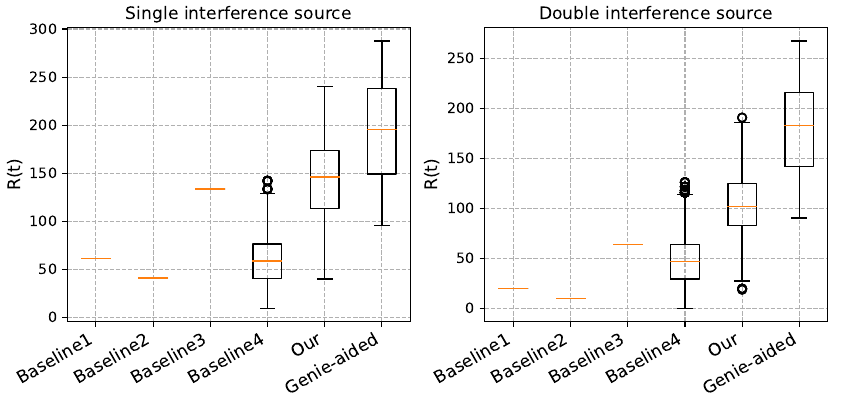
Figure 5. The box plot of total throughput for 100 time slots in each training episode under the simulation data.